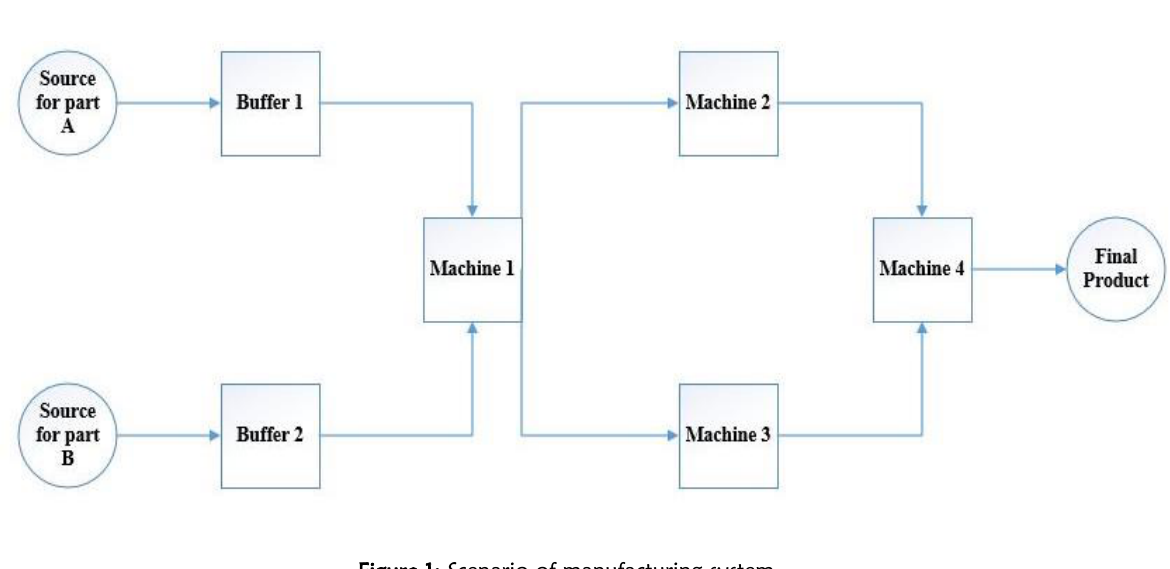
Figure 1: Scenario of manufacturing